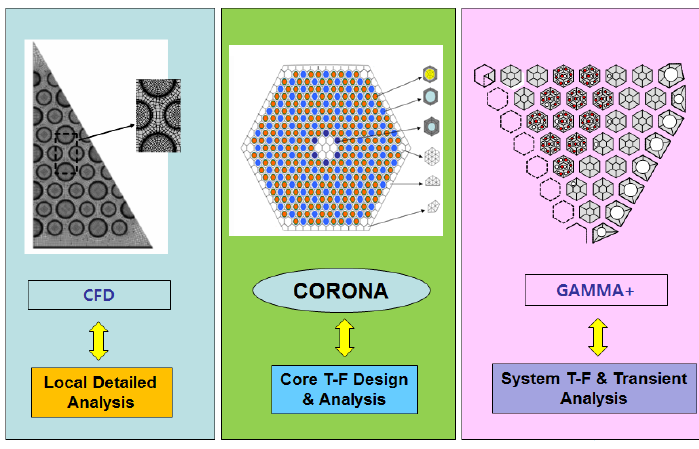
Figure 2. Thermal - Fluid Analysis Codes of a Block - type HTGR Core in KAERI